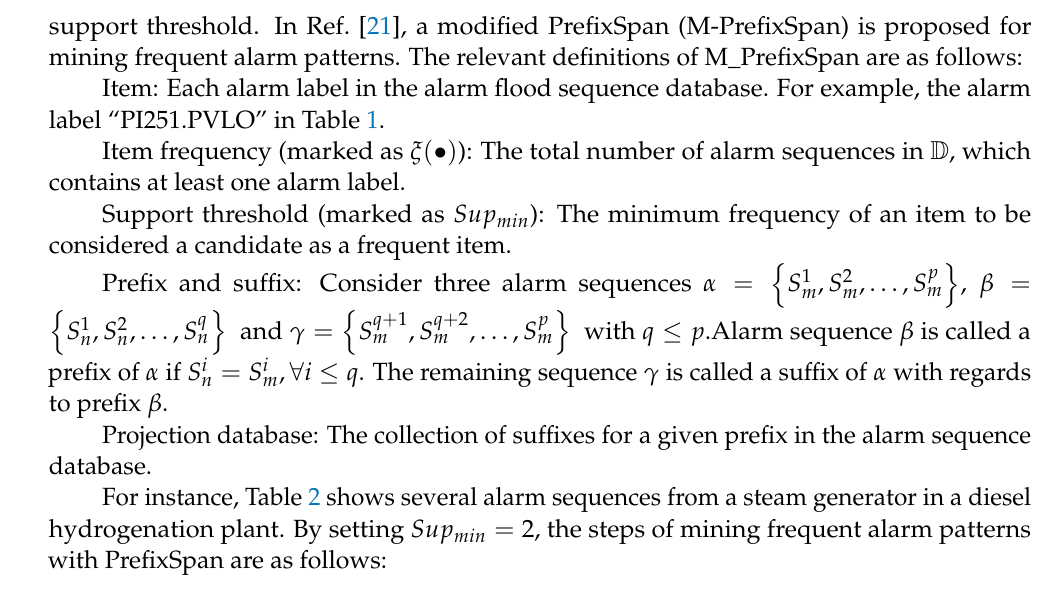
Table 2. Alarm sequences for a steam generator in a diesel hydrogenation